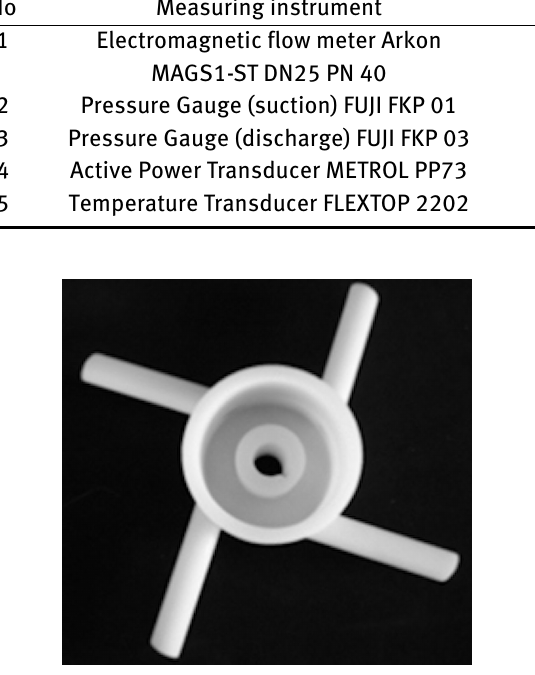
Figure 3: Geometry of the impeller 3 (I3)